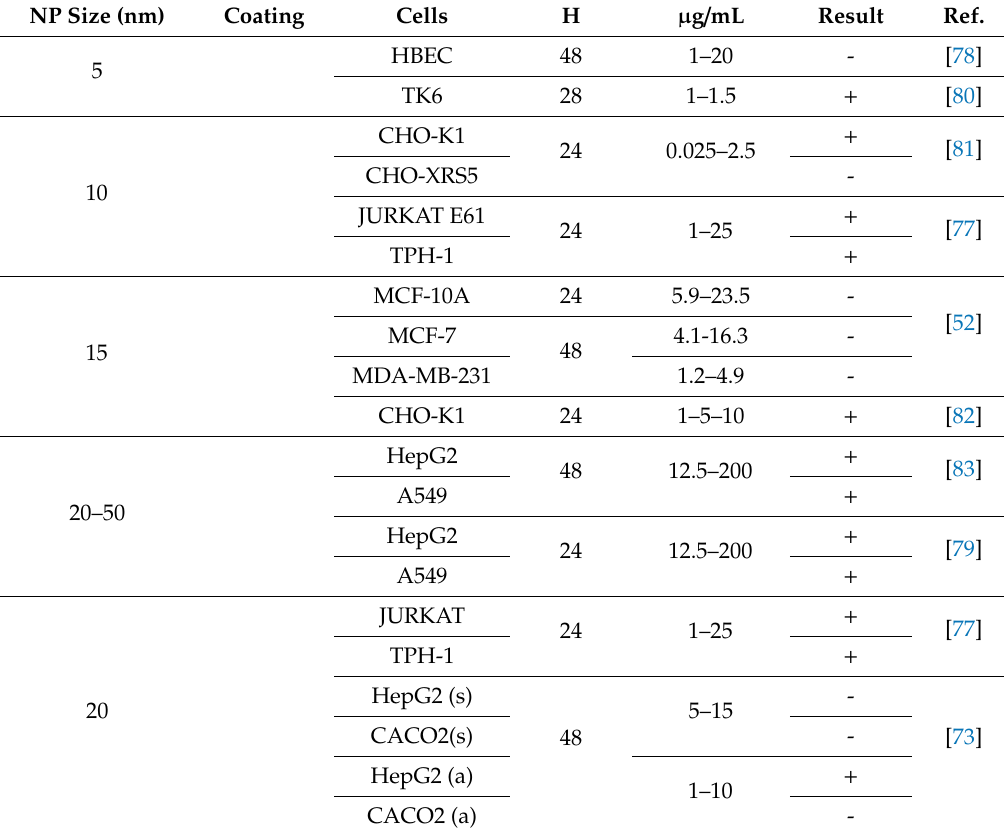
Table 2. In vitro micronucleus assay